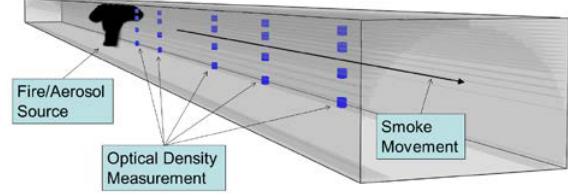
Fig. 1 . Scheme of the